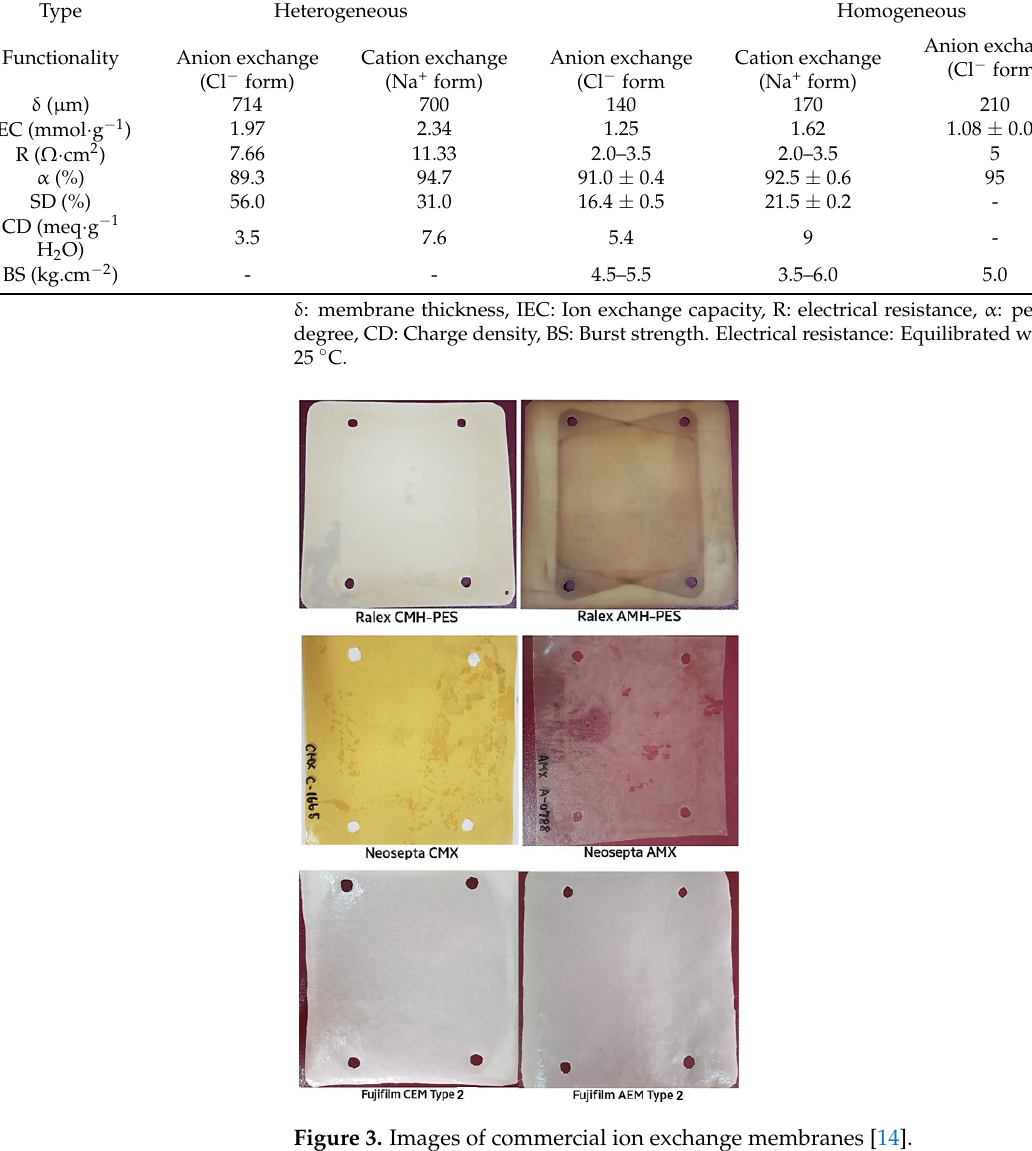
Table 3. The properties of ion exchange membranes used in RED tests.